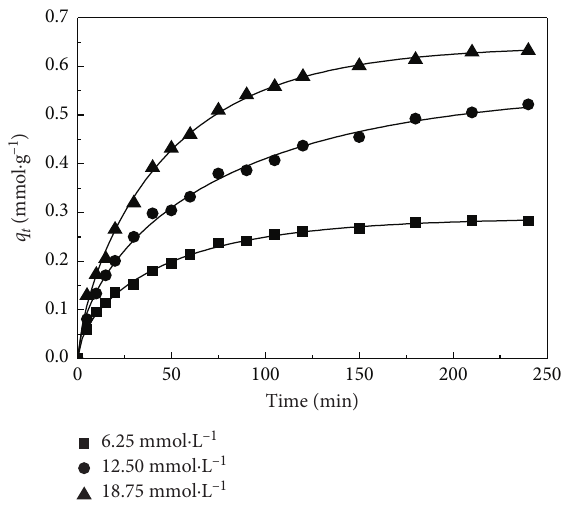
Figure 16: Nonlinear fitting of MPnO model (adsorbent: 0.2g 2wt. %; v : 20mL; c 0 : 6.25, 12.50, and 18.75 mmol · L − 1 DBT; adsorption oil time: 4h; adsorption temperature: